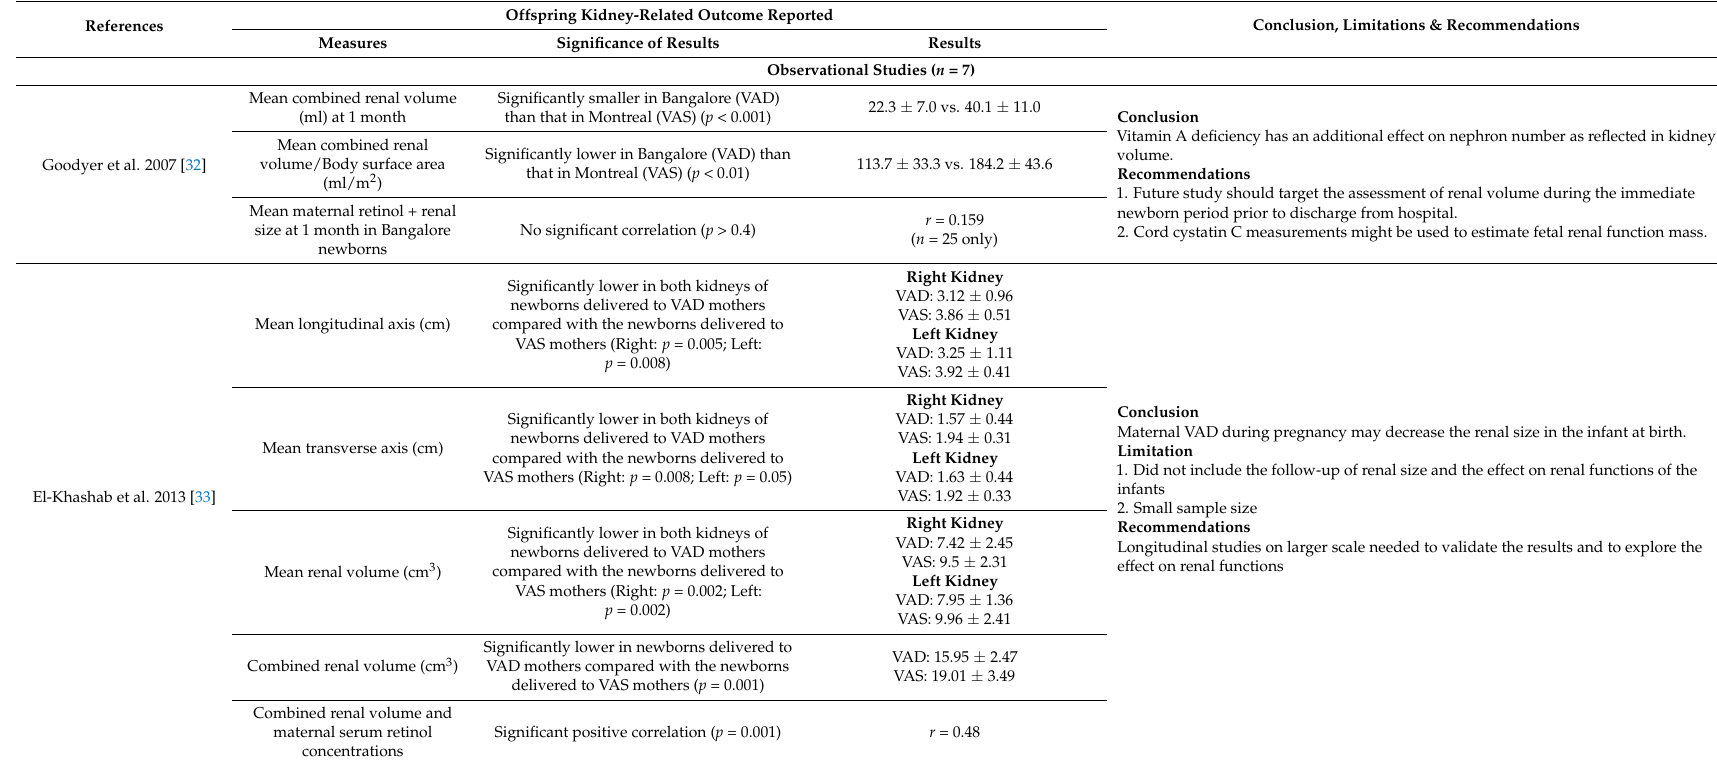
Table 4. Results of observational